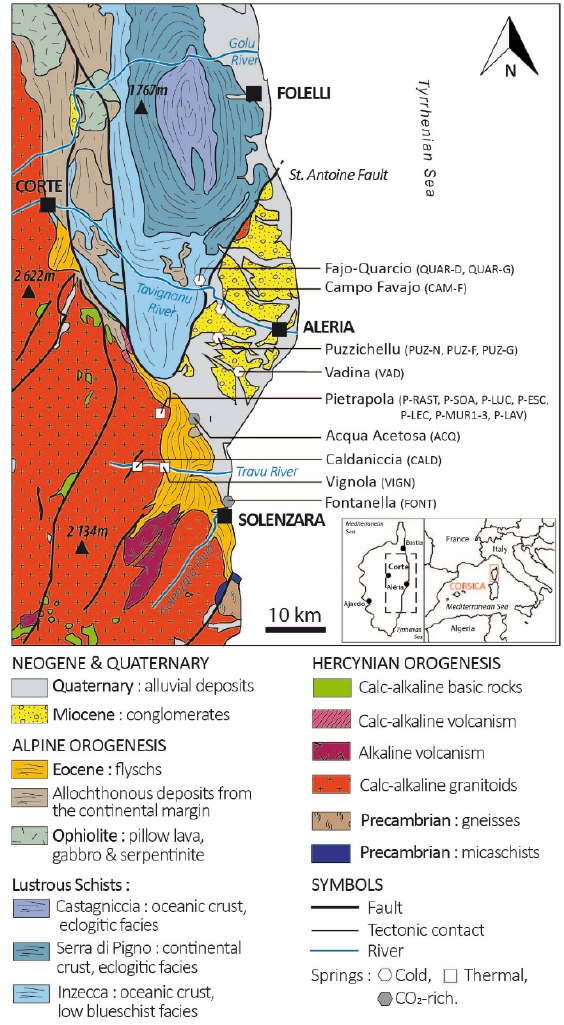
Figure 1. Location of the study area with geology, topography, hydrography and distribution of mineral and thermal waters from the eastern part of Corsica Island (France). Symbols: white square depicts thermal springs, grey hexagon depicts CO 2 -rich springs and white hexagon depicts cold springs.